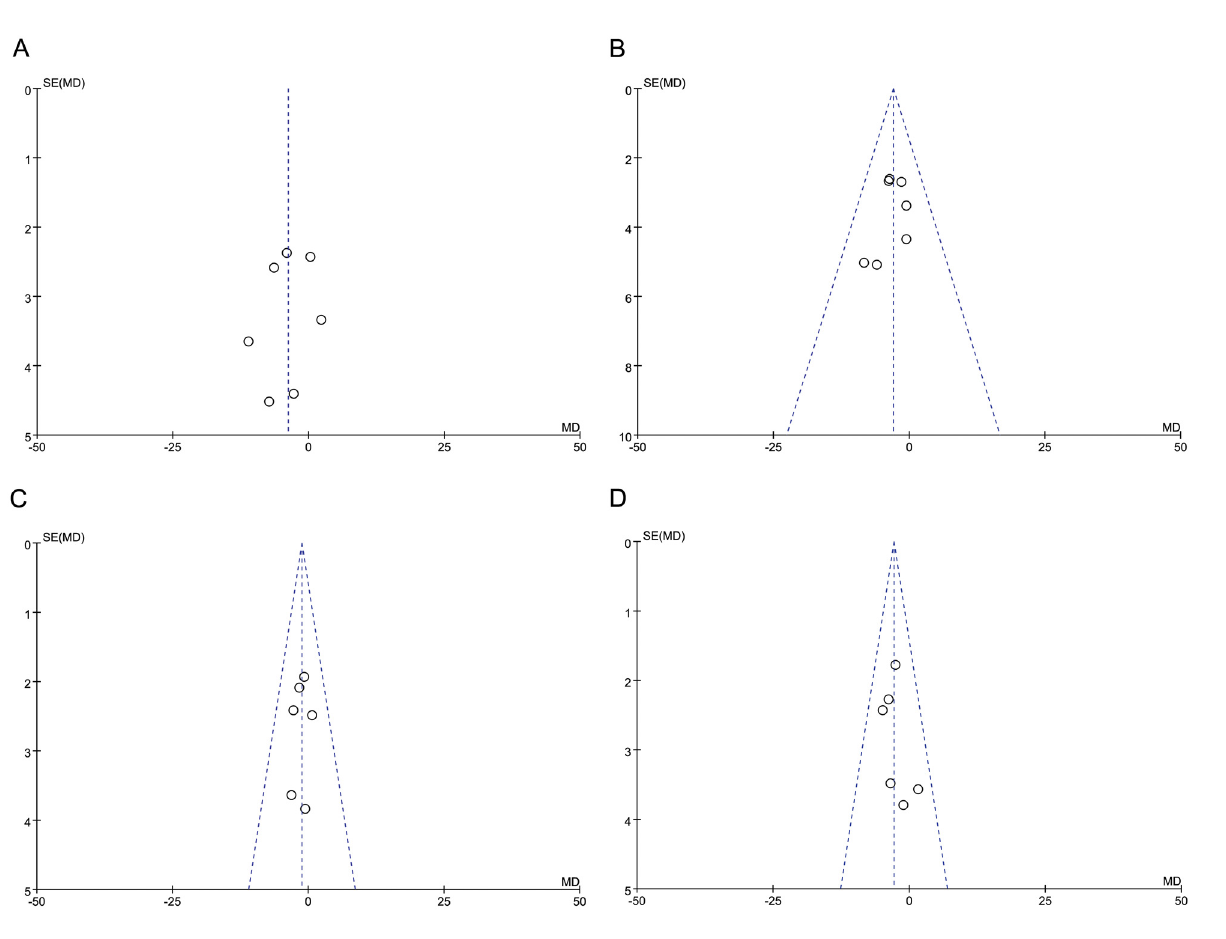
Fig 7. Funnel plot of studies assessing RNFL thickness in four quadrants using OCT. A, superior; B, inferior; C, temporal; D, nasal.